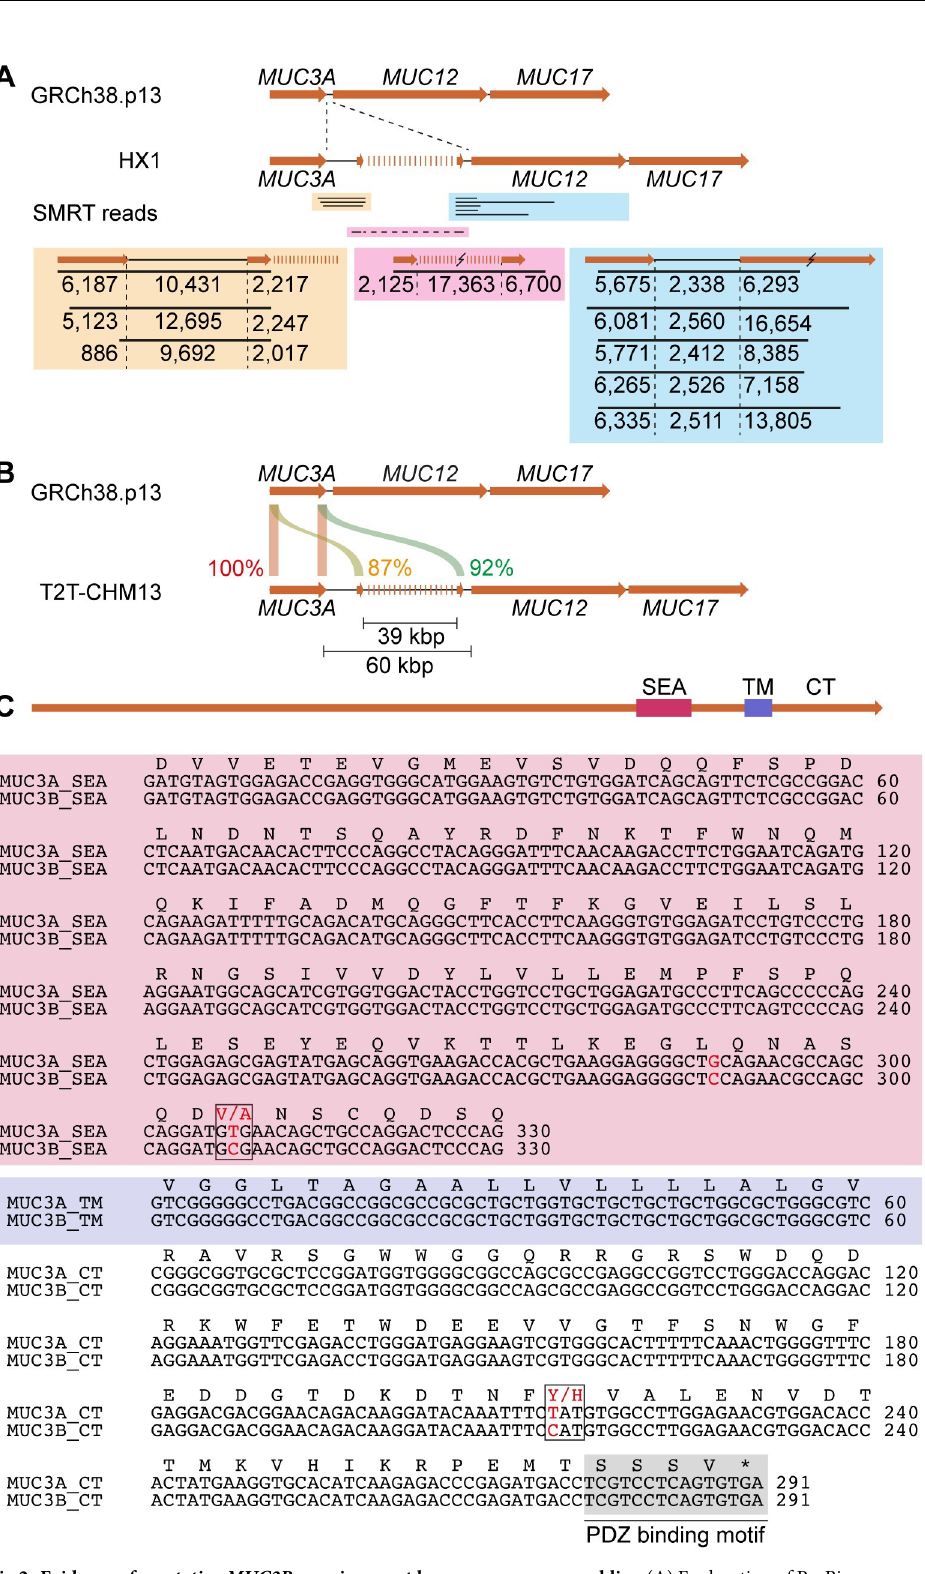
Fig 2. Evidence of a putative MUC3B gene in recent human genome assemblies. (A) Exploration of PacBio sequencing of HX1 genome identified SMRT reads covering the intergenic region between MUC3A and putative MUC3B , an incomplete PTS sequence, and intergenic sequences between putative MUC3B and MUC12 . (B) The